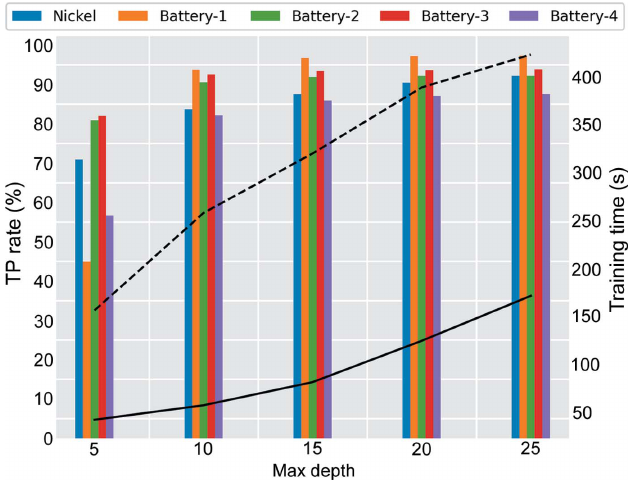
Figure 5 TP rate results for the datasets. The solid and dashed curves represent GPU and multi-core CPU training times as a function of gradient boosting tree depth.